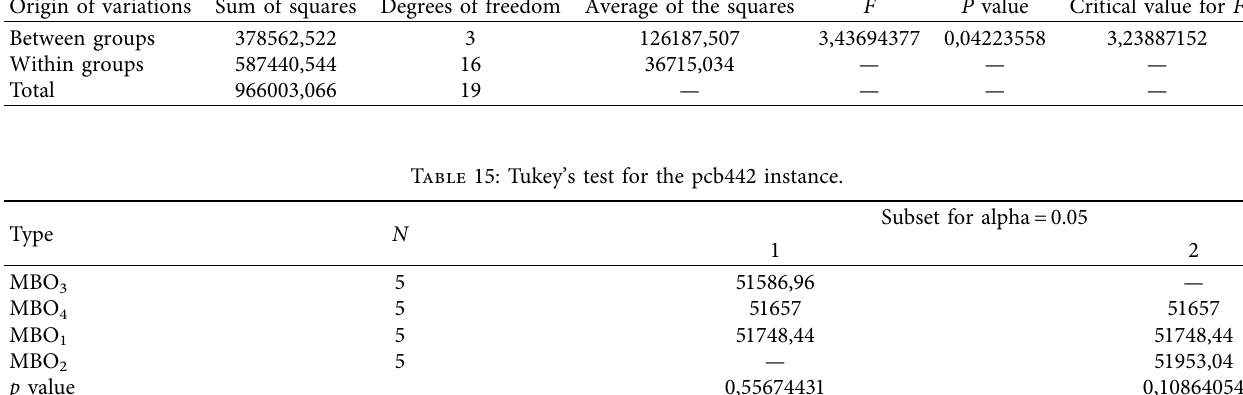
Table 14: ANOVA for the pcb442 instance. Origin of variations Sum of squares Degrees of freedom Average of the squares